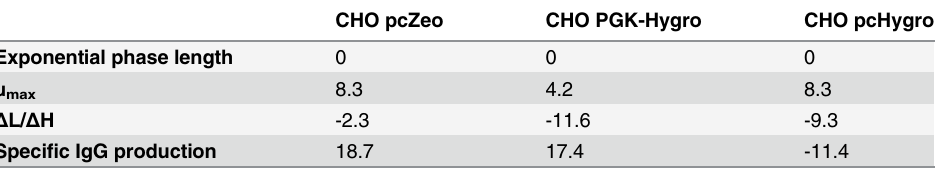
Table 2. Percentage variation for control cultures ’ parameters compared to a parental cell culture CHO